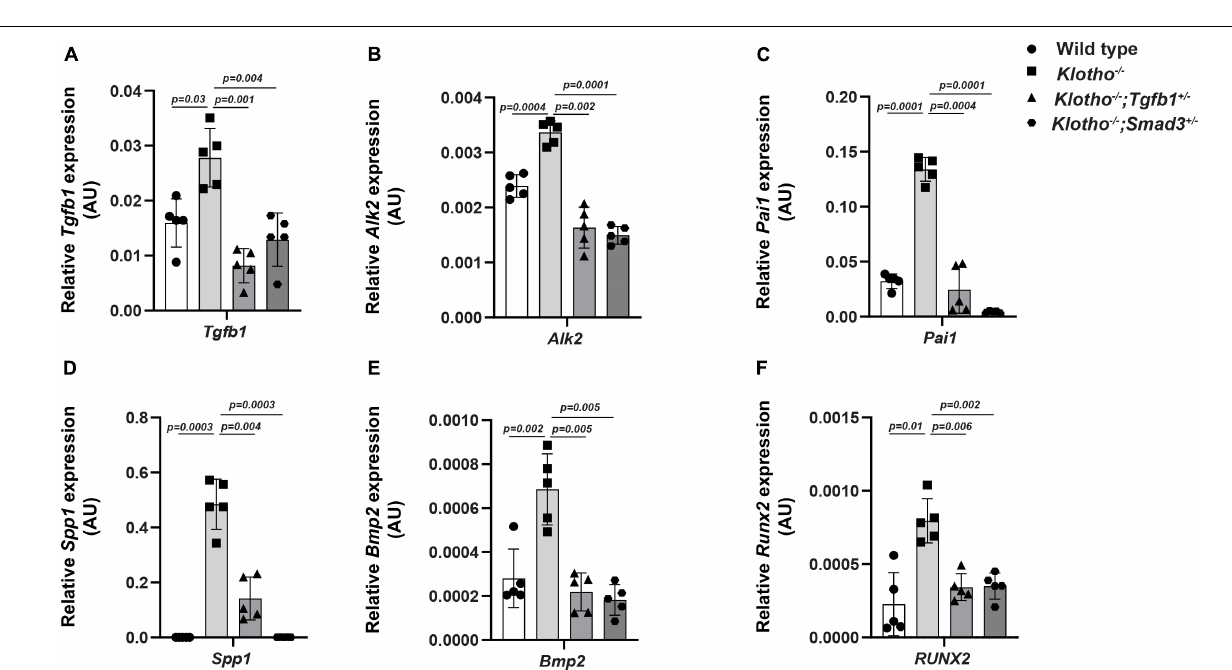
FIGURE 4 | Partial genetic inactivation of Tgfb1 and Smad3 inhibits AV calcification in 10–12-week-old Kl − / − mice. (A–H) Alizarin red staining of aortic valve in wild-type (A,E) , Kl − / − (B,F) , Kl − / − ;Tgfb1 ± (C,G) , and Kl − / − ;Smad3 ± (D,H) mice. Images (E–H) are the magnified views of the corresponding boxed region (A–D) . Scale bars = (A–D) , 200 µ m; (E–F) , 50 µ m. (I) Quantitative analysis of calcification. Quantification of calcification was done on multiple serial sections from each animal per group by using NIH-Image J software. Values indicate mean ± SD , and significant “ p -values” were given on the top of histograms.